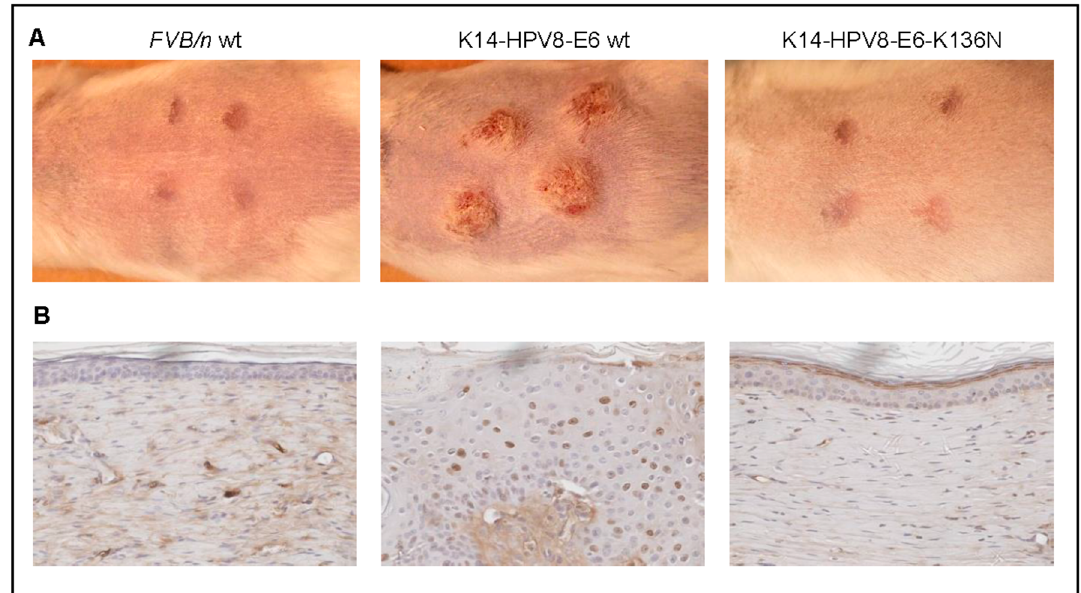
Figure 2. Persistence of DNA damage in full-thickness wounded K14-HPV8-E6 wt mice. Five weeks old FVB/n wt, K14-HPV8-E6 wt and K14-HPV8-E6K136N mice ( n = 8 for each mouse line) were anaesthetized and wounded dorsal-caudal. Four punch biopsies were taken from the skin of the back creating four circular 4-mm wounds according to previously published procedures [37].